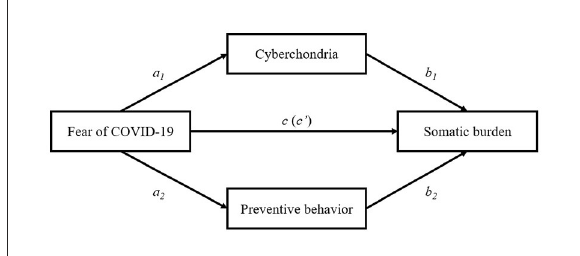
FIGURE1 Proposed multiple mediation model; Direct and indirect effects of COVID-19 fear on somatic burden. c – total effect; c’ – direct